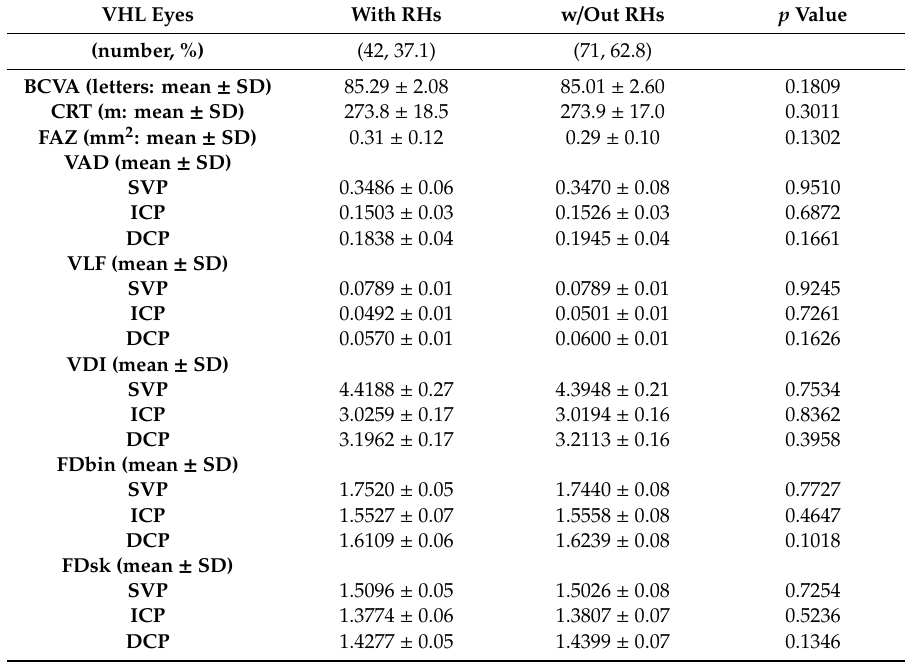
Table 3. Best corrected visual acuity, OCT and OCT angiography parameters in VHL eyes with or without peripheral retinal hemangioblastomas